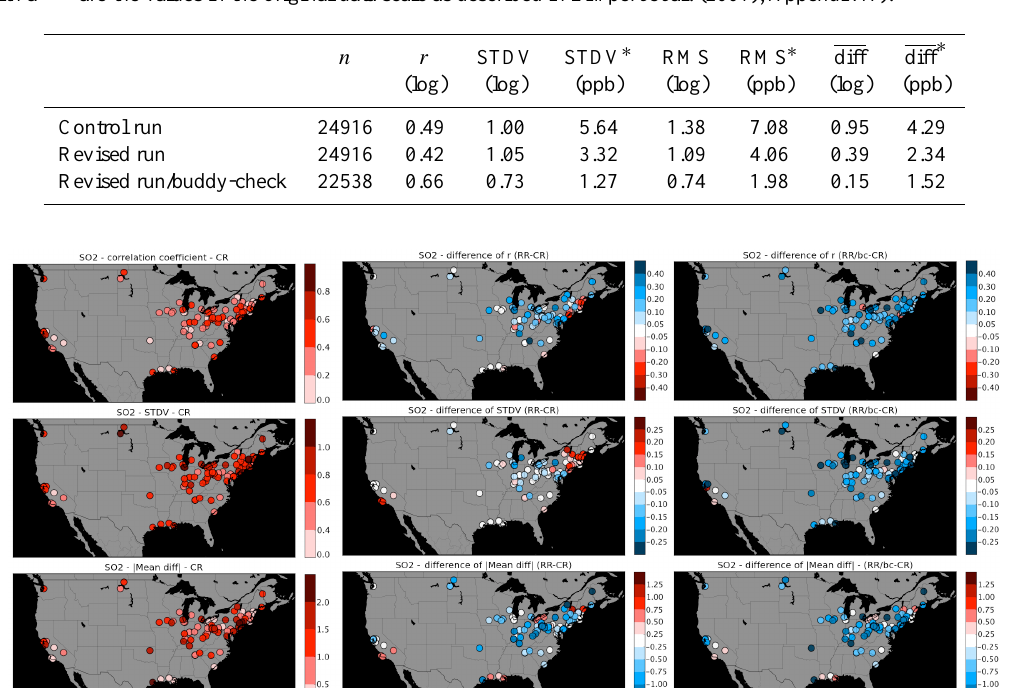
Table 2. Summary of SO 2 surface comparison results ( n is the number of points; r is the correlation coefficient; RMS is the Root-Mean- Square of the differences; STDV is the standard deviation of the differences and diff is the mean difference in the logarithmic scale, the parameters with a “ ∗ ” are the values in the original data scale as described in Limpert et al. (2001), Appendix A).